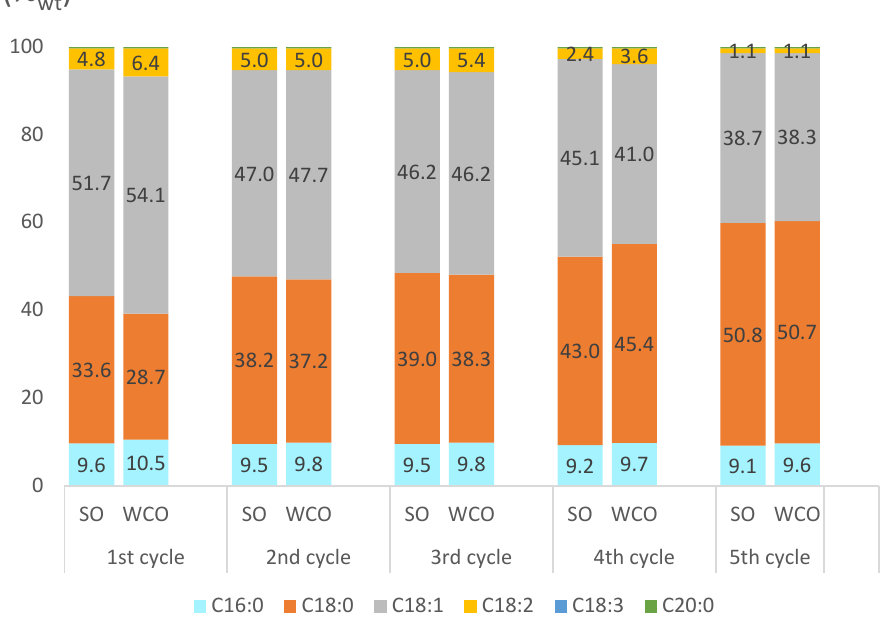
Figure 4. SO and WCO FAME composition (% wt ) after each of five subsequent runs with the same Pd-pol catalyst. Reaction conditions: SO or WCO biodiesels (125 mg), Pd-pol (0.014 mmol of Pd), CH 3 OH (5 mL), RT, H 2 (10 bar), t = 5 min. In all histograms, the percent of C20:0 methyl ester is equal to 0.3%.